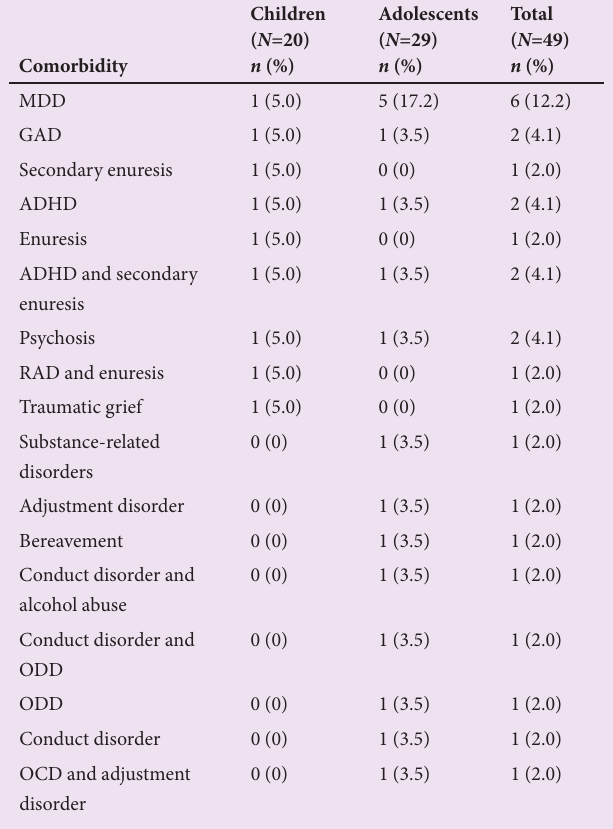
Table 3. Associated mental disorders (comorbidity) diagnosed in participants with